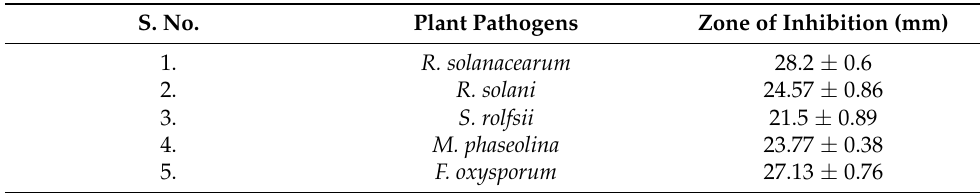
Table 1. Antagonistic activity of P. fluorescens VSMKU3054 against R. solanacearum and fungal plant